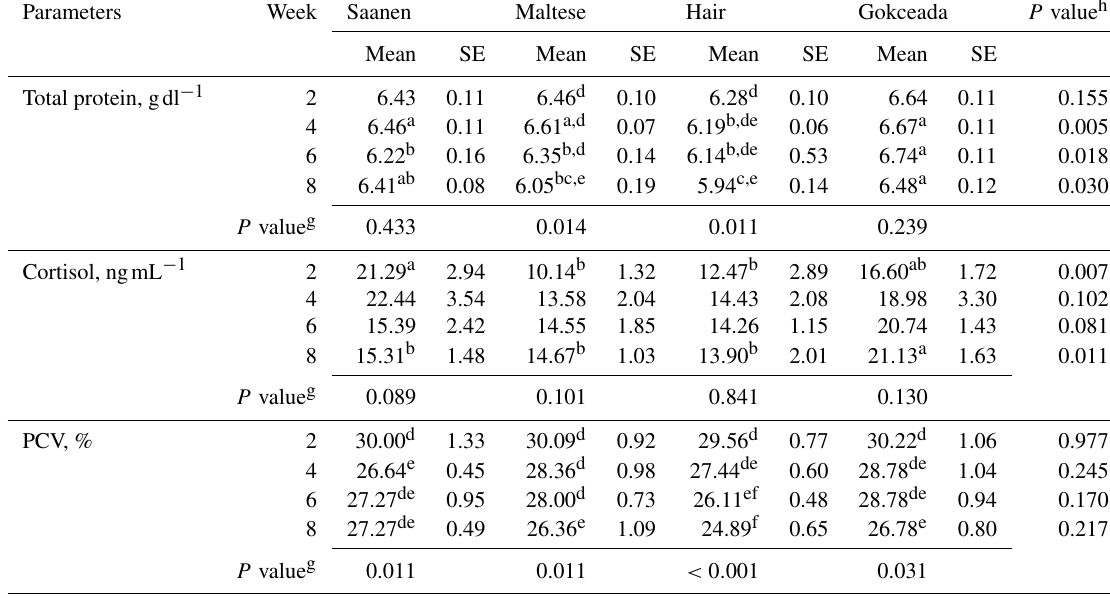
Table 3. Packed cell volume (PCV) and plasma cortisol and total protein levels in different periods of fattening due to breed. Parameters Week Saanen Maltese Hair Gokceada P value h Mean SE Mean SE Mean SE Mean SE Total protein, gdl − 1 2